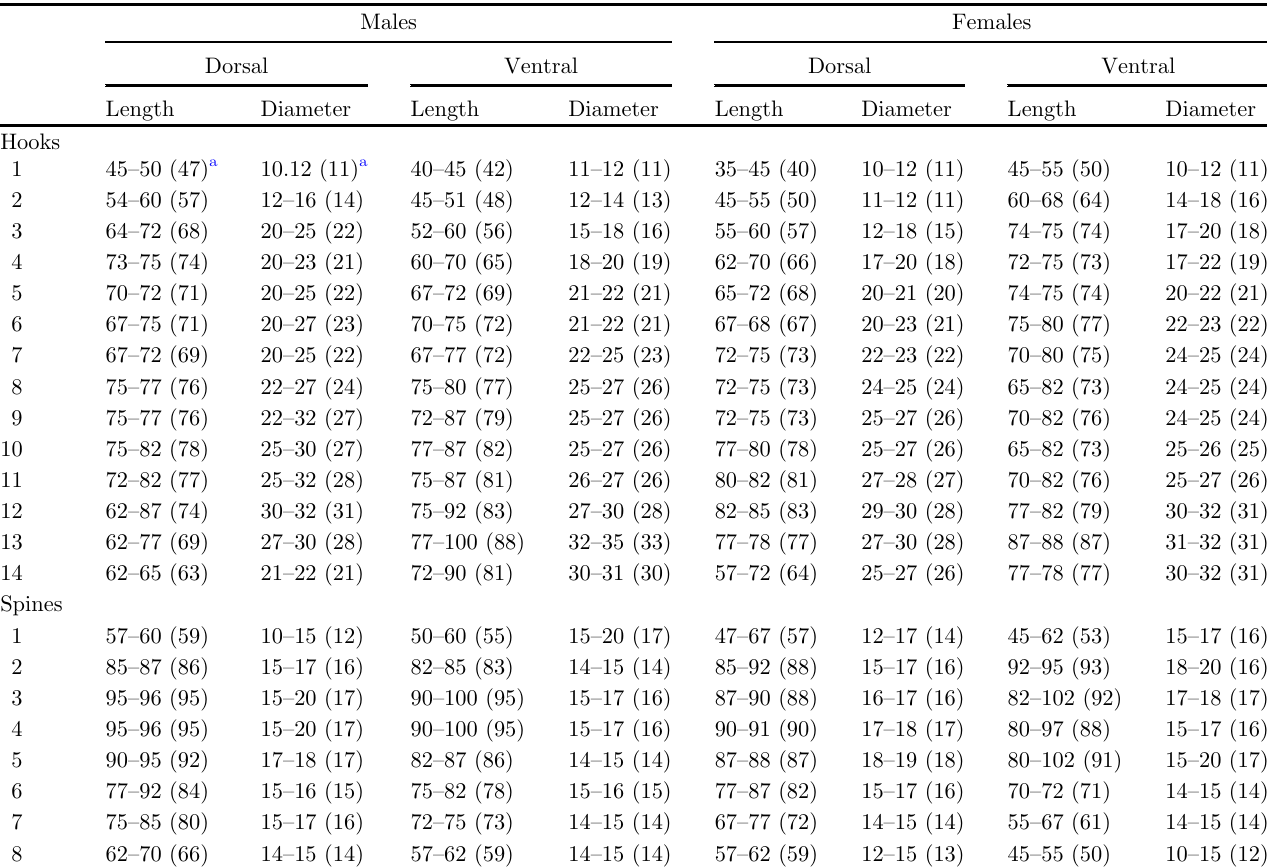
Table 2. Measurements of dorsal and ventral proboscis hooks and spines of 3male and 3female cystacanths of Neoandracantha peruensis